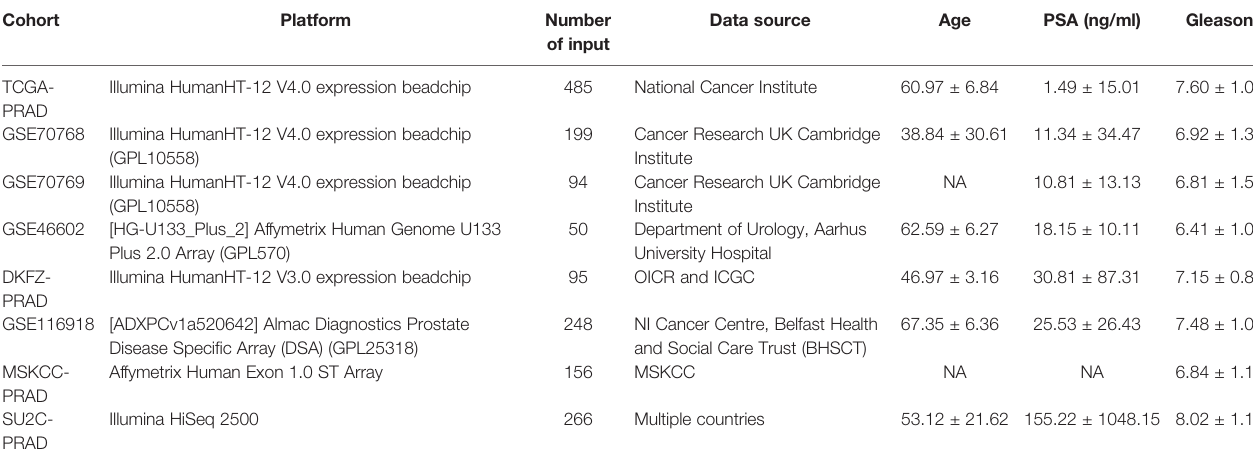
TABLE 1 | Detailed information of PCa cohort used for combination in the